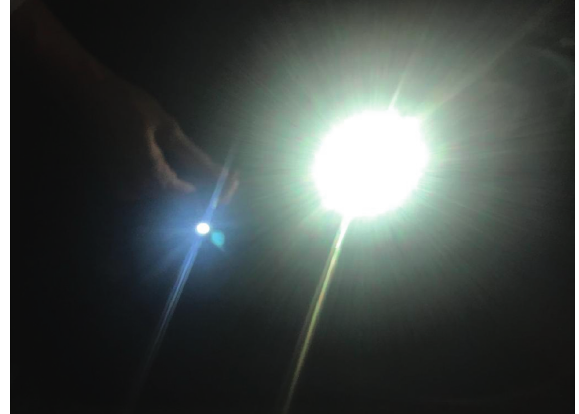
Figure 6: Light emitted by the endoscope and iPhone 6